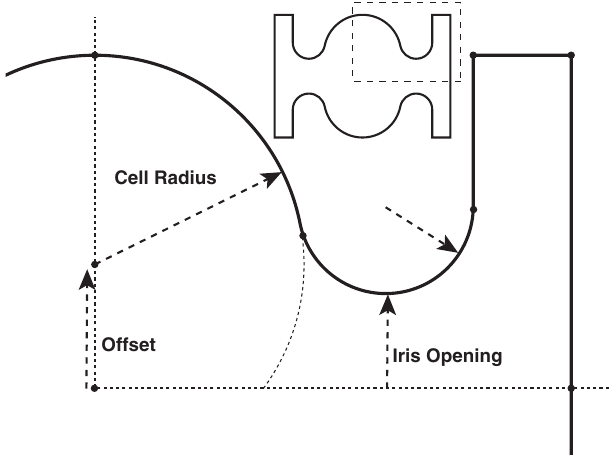
FIG. 5. Racetrack input coupler geometry; one quarter of the full cell is shown inset. The standard (round) coupler corre- sponds to an offset of zero.